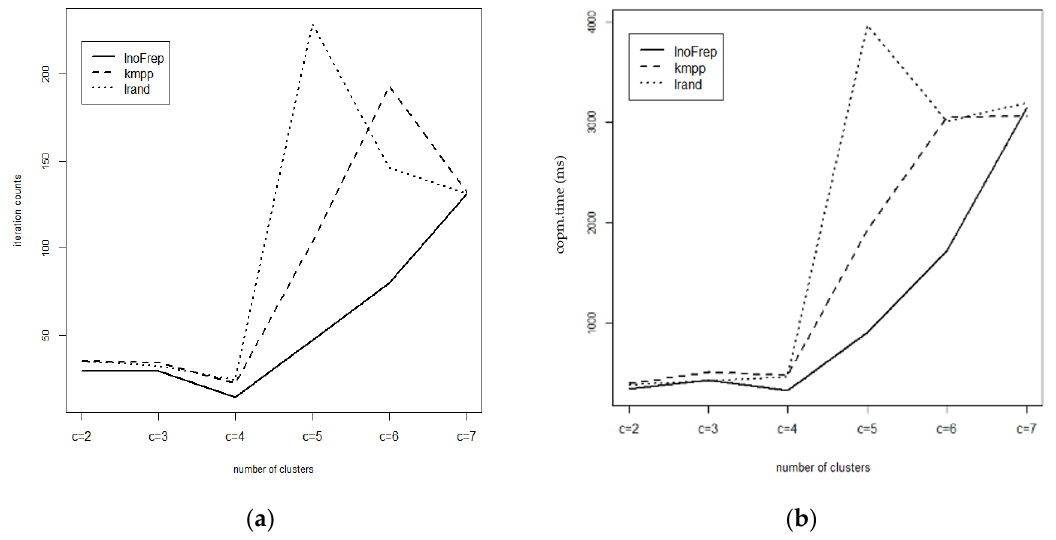
Figure 3. ( a ) Iteration counts by the number of clusters ( b ) Computing time (ms) required in the number of clusters.